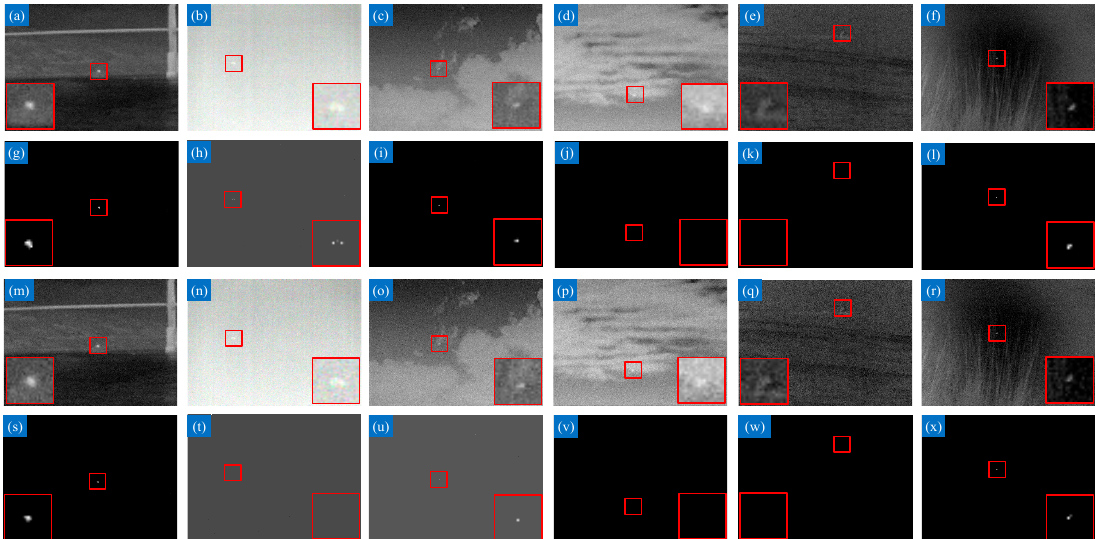
Figure A10. The first and third row show infrared images with additive white Gaussian noise with standard deviation of 10 and 20, and the second and fourth rows are the corresponding detection results by NIPPS.